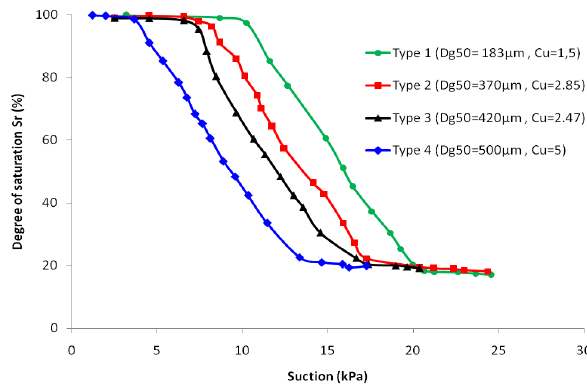
Figure 14: Water retention curves for type 3 sand for different density index